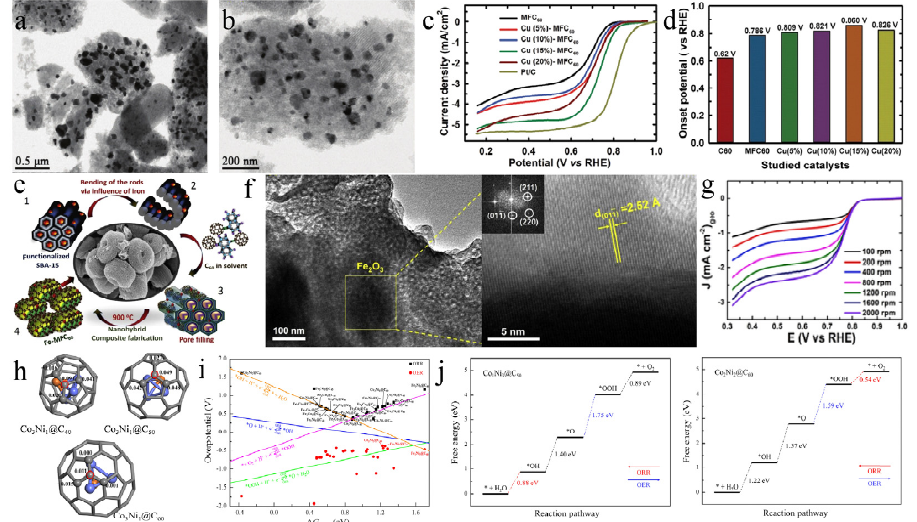
Figure 5. ( a ) Low and ( b ) high resolution TEM images of Cu(15%)-MFC 60 . ( c ) Consolidated ORR polarization curves were recorded at 1600 rpm in O 2 -saturated 0.1 M KOH (scan rate: 10 mV s − 1 ) for the studied catalysts. ( d ) The respective onset potential. Reproduced with permission [61].